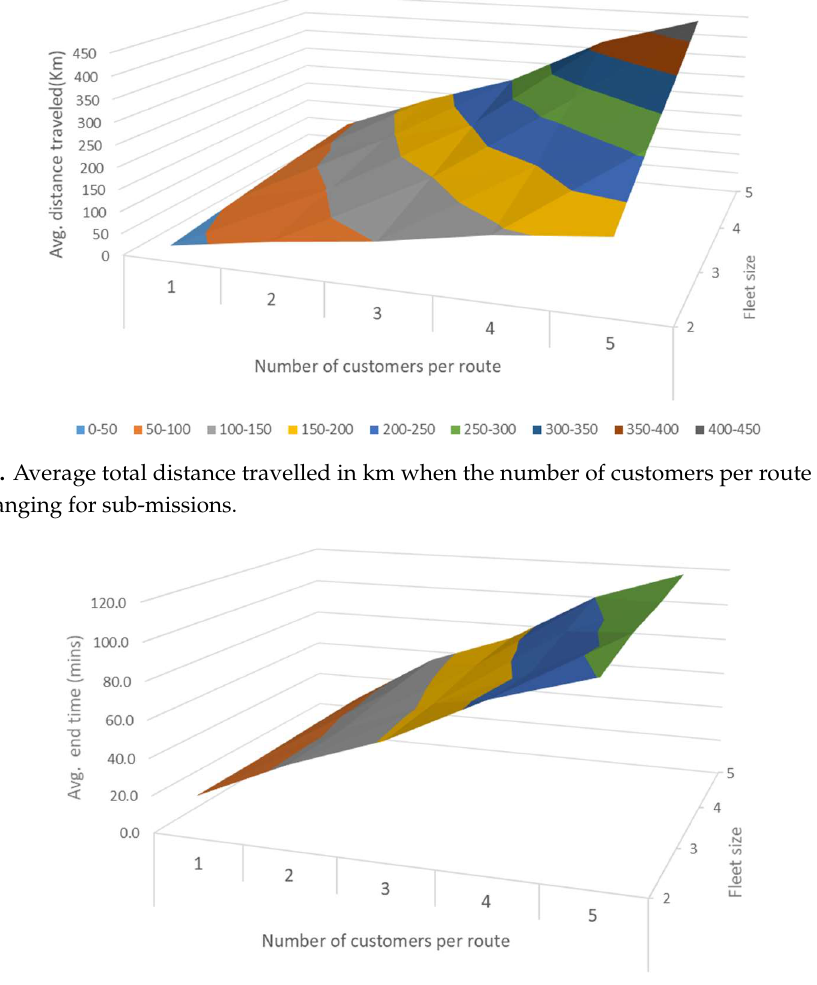
Figure 14. The average end time of sub-missions in minutes when the number of customers per route and fleet size is changing for sub-missions.